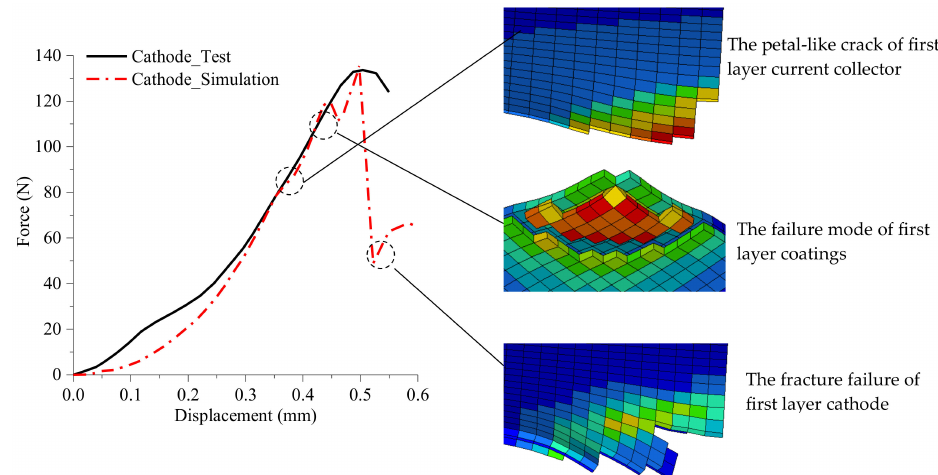
Figure 15. Comparison of experimental and simulated force-displacement curve and numerically prediction failure evolution of cathode in multilayered LEMs during local indentation.